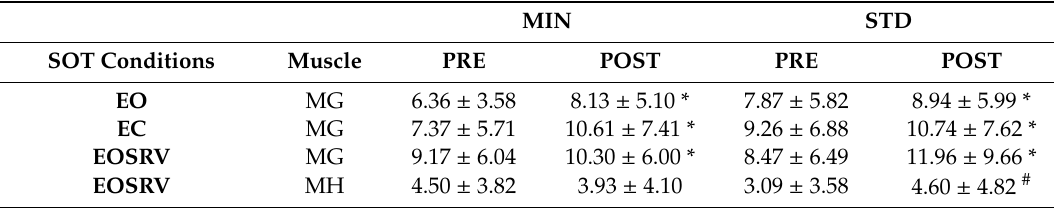
Table 3. Descriptive statistics for mean muscle activity (mV) during sensory organization